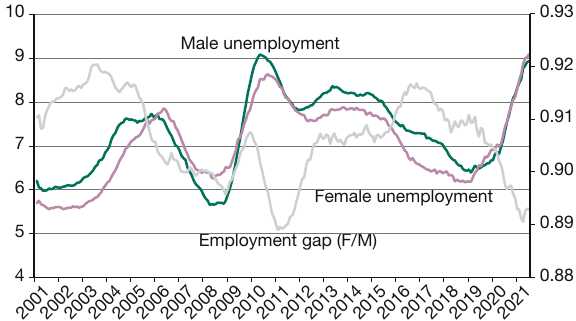
Figure 1 Unemployment rate for men and women and the change in the employment